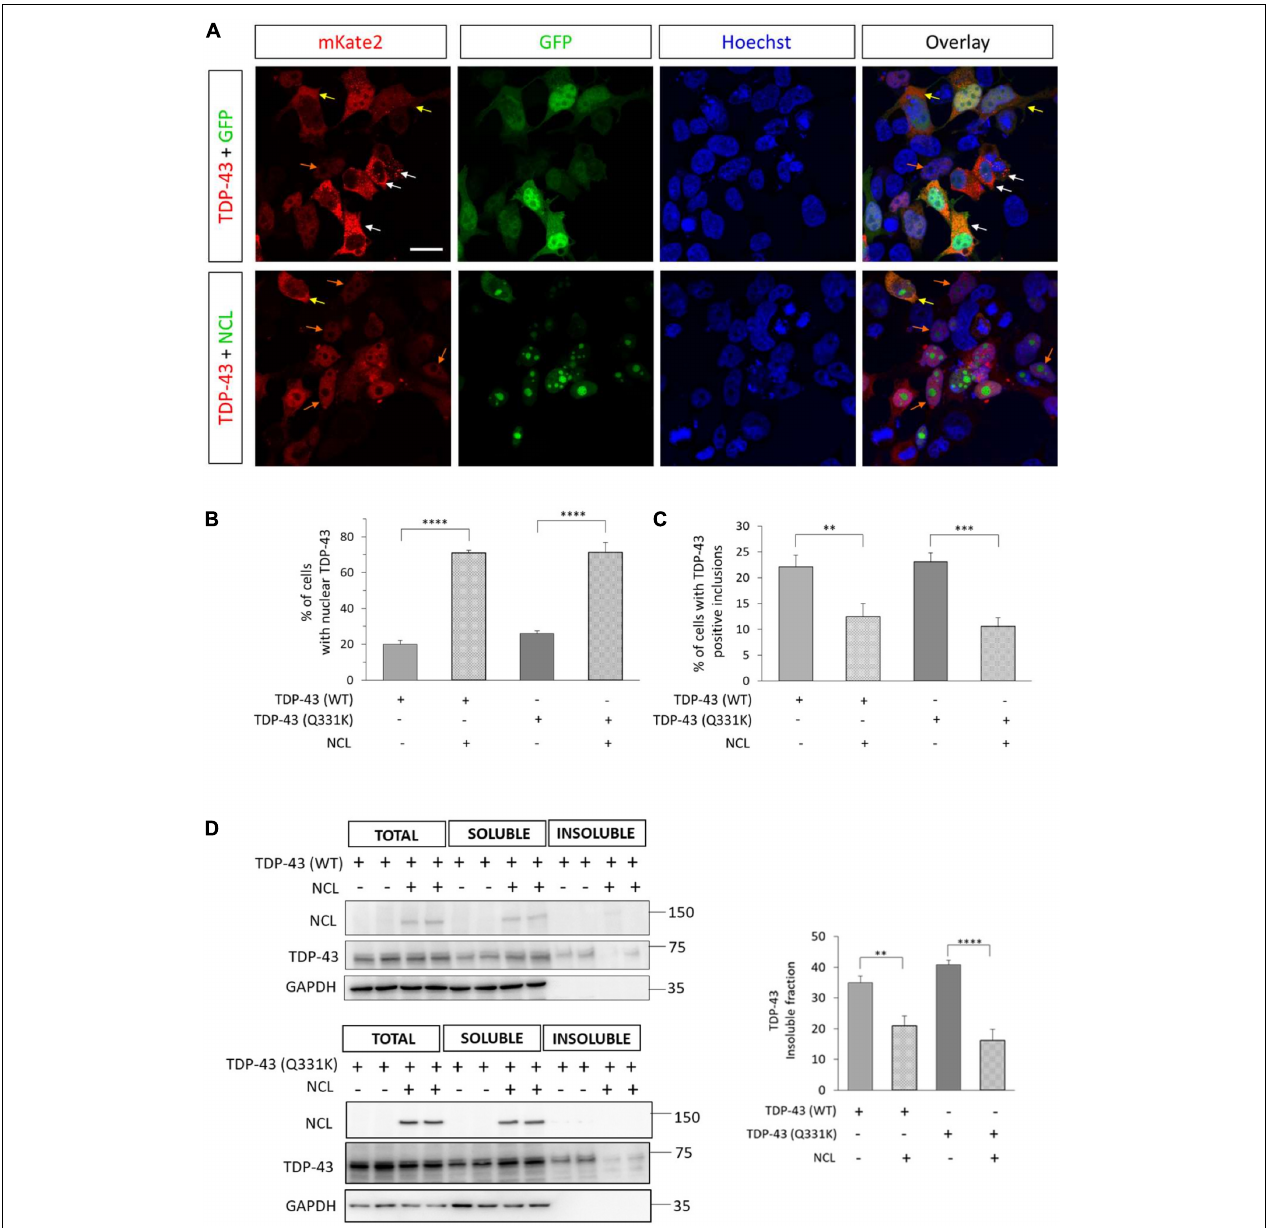
FIGURE 9 | NCL rescued the nuclear localization of TDP-43, and reduced cytosolic inclusions and the detergent-insoluble fraction of TDP-43 in HEK293T cells. (A) Confocal microscopy analysis of HEK293T cells co-transfected with plasmids coding for human WT TDP-43 fused to mKate2 and either GFP alone (TDP-43 + GFP, upper panels), or the NCL-GFP chimera (TDP-43 + NCL, lower panels), and counterstained with the nuclear marker Hoechst. The reported micrographs, representative of three biological replicates, show cells with nuclear (orange arrows) or uniform cytosolic (yellow arrows) localization of TDP-43-mKate2, or intense discrete cytosolic red signals suggestive of the presence of TDP-43-mKate2 inclusions (white arrows). Scale bar , 20 µ m. (B) Percentage of cells co-expressing TDP-43-mKate2 (either WT or bearing the Q331K mutation) and GFP (–) or NCL-GFP (+) having an exclusively nuclear mKate2 signal, with respect to the total of cells co-expressing both proteins. n = 3; ∗∗∗∗ p < 0.0001, one-way ANOVA followed by Sidak’s test for multiple comparisons. (C) Percentage of cells co-expressing either the WT or the Q331K mutant of TDP-43-mKate2 chimera and GFP (–) or NCL-GFP (+), presenting discrete (cytosolic) aggregation-like foci, with respect to the total of cells co-expressing both proteins. n = 3; ∗∗ p < 0.01, ∗∗∗ p < 0.001, one-way ANOVA followed by Sidak’s multiple comparison test. (D) Representative WBs (left panel) of RIPA-soluble and -insoluble fractions of lysates from HEK293T cells co-transfected with TDP-43-mKate2 (either WT, upper part, or carrying the Q331K mutation, lower part) and either GFP alone ( ± ), or the NCL-GFP chimera (+/+). As control, total lysates were loaded. The presence of NCL-GFP (with anti-GFP antibody), TDP-43-mKate2 (with anti-TDP-43 antibody) and GAPDH (as control for detergent-soluble proteins) were analyzed. The percentage of insoluble TDP-43-mKate2 in the different analyzed samples is shown in the right panel. n = 5 for TDP-43(WT), n = 3 for TDP-43(Q331K); ∗∗ p < 0.01, ∗∗∗∗ p < 0.0001, one-way ANOVA followed by Sidak’s multiple comparison test.